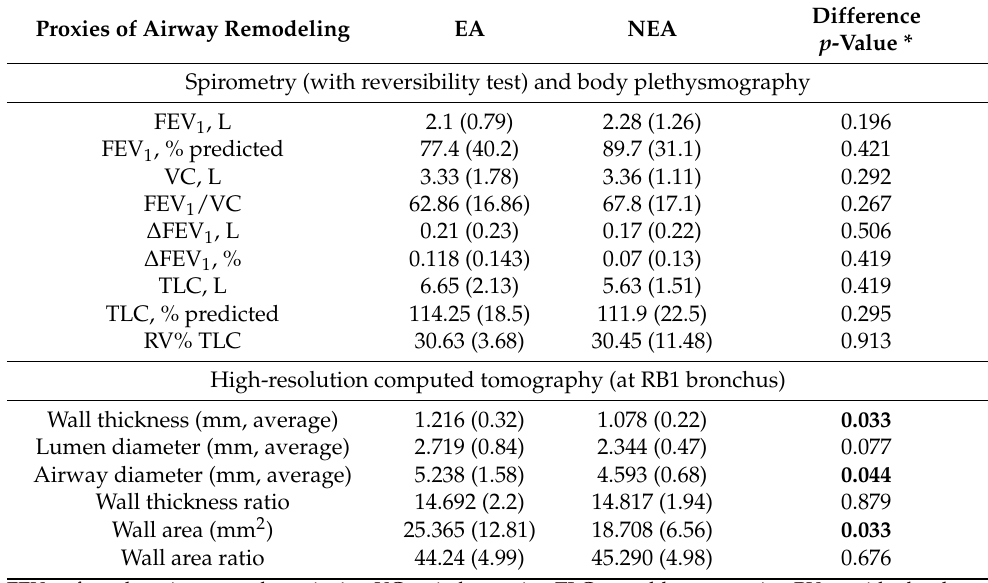
Table 2. Sample’s spirometry and high-resolution computed tomography proxies of airway remodeling. Proxies of Airway